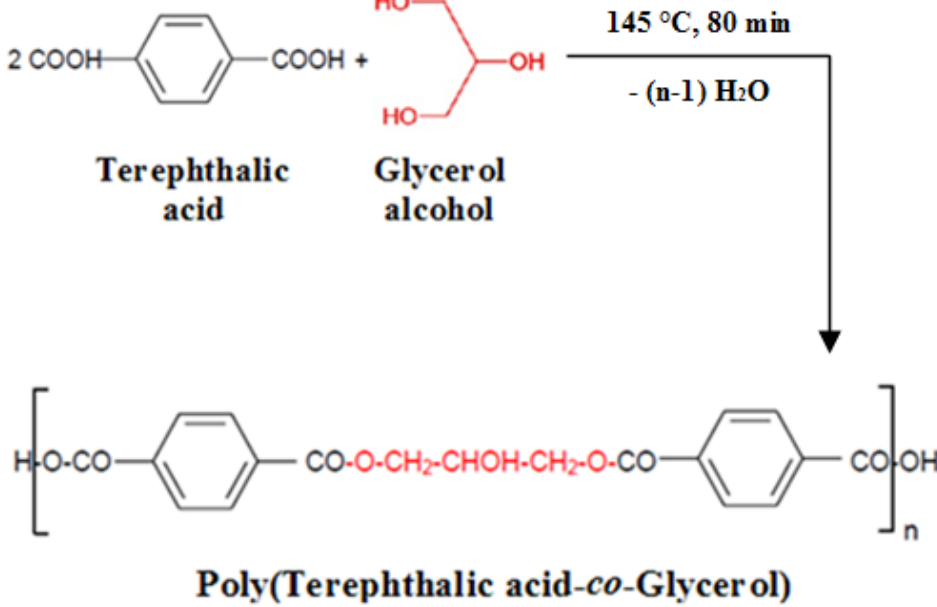
Scheme 1. Schematic diagram of the co-polymer